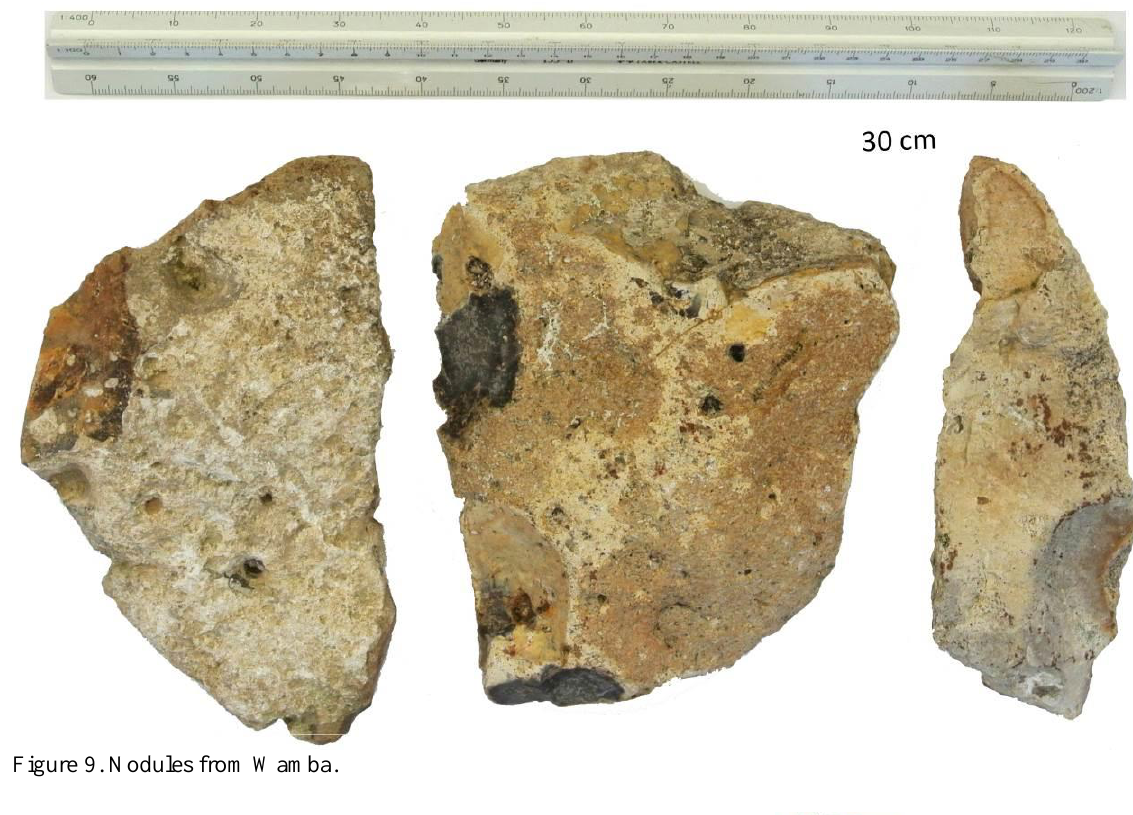
Figure 9. Nodules from Wamba.